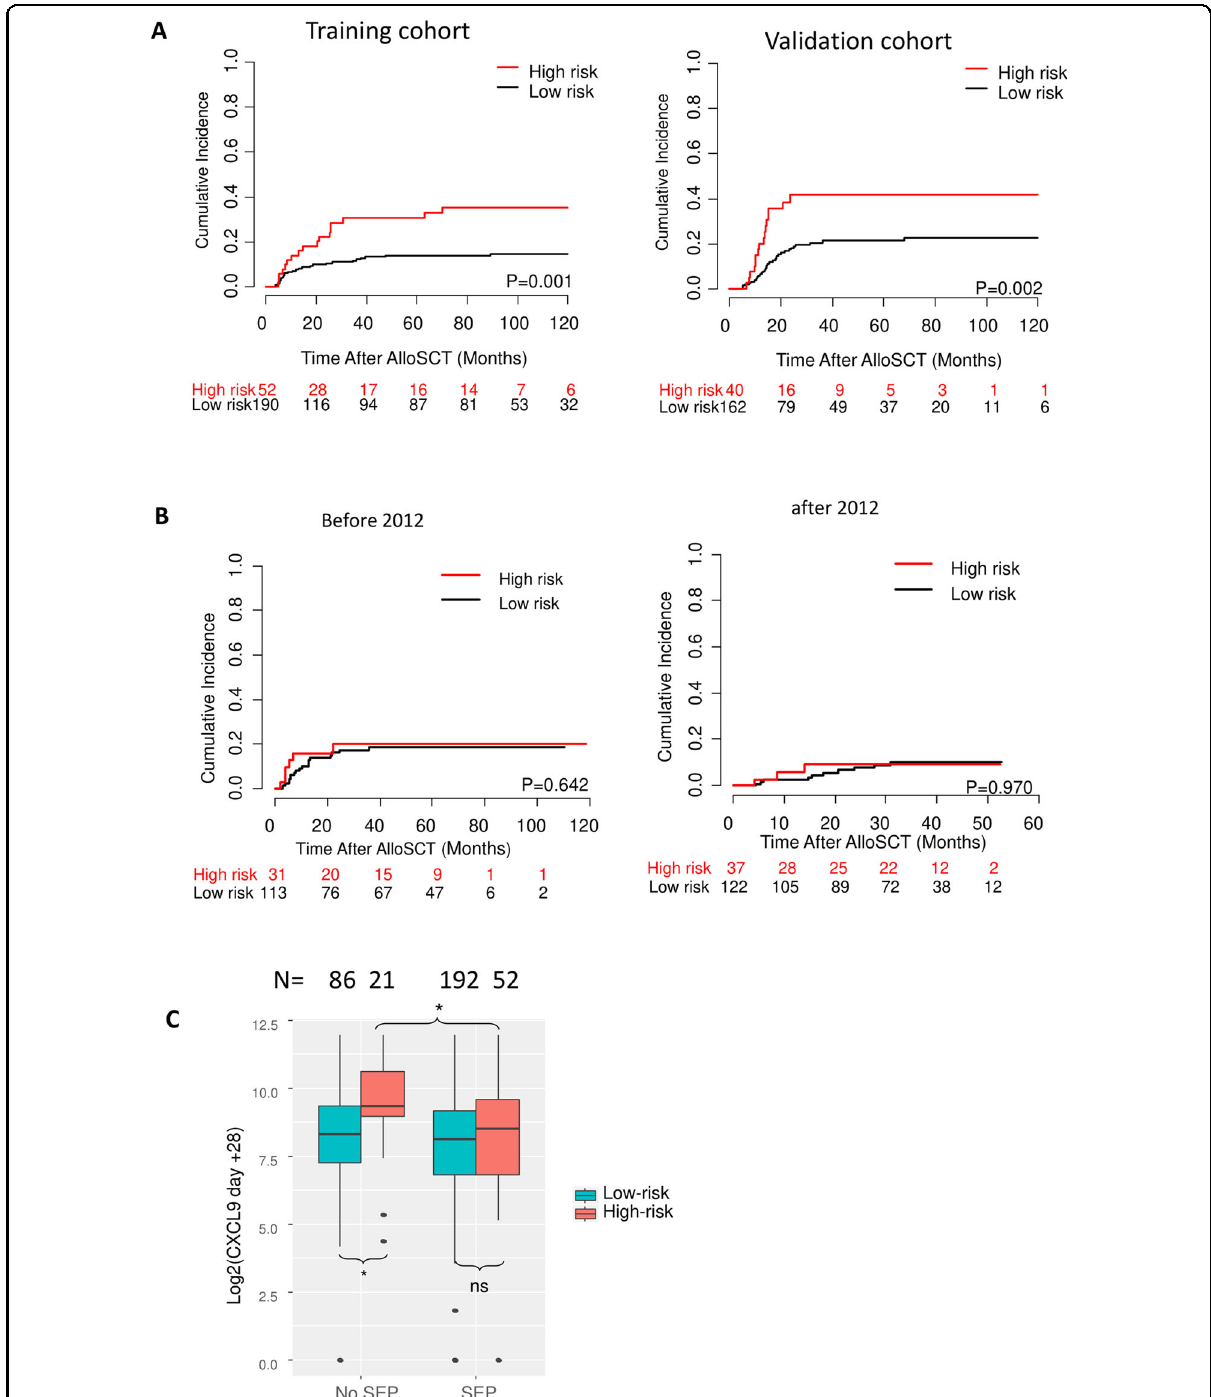
Fig. 2 The effect of genetic risk (CXCR3 ligands) on severe chronic graft-versus-host disease (GVHD). A Association of the combined genetic risk group with the incidence of severe chronic GVHD in the training cohort and validation cohort. B No difference could be observed between the genetic risk groups in patients with SEP in two consecutive cohorts ( n = 144 and 159, respectively). C Association of serum CXCL9 levels at day + 28 with the combined genetic risk group in patients without and with SEP. n.s. not signi fi cant; * P ≤